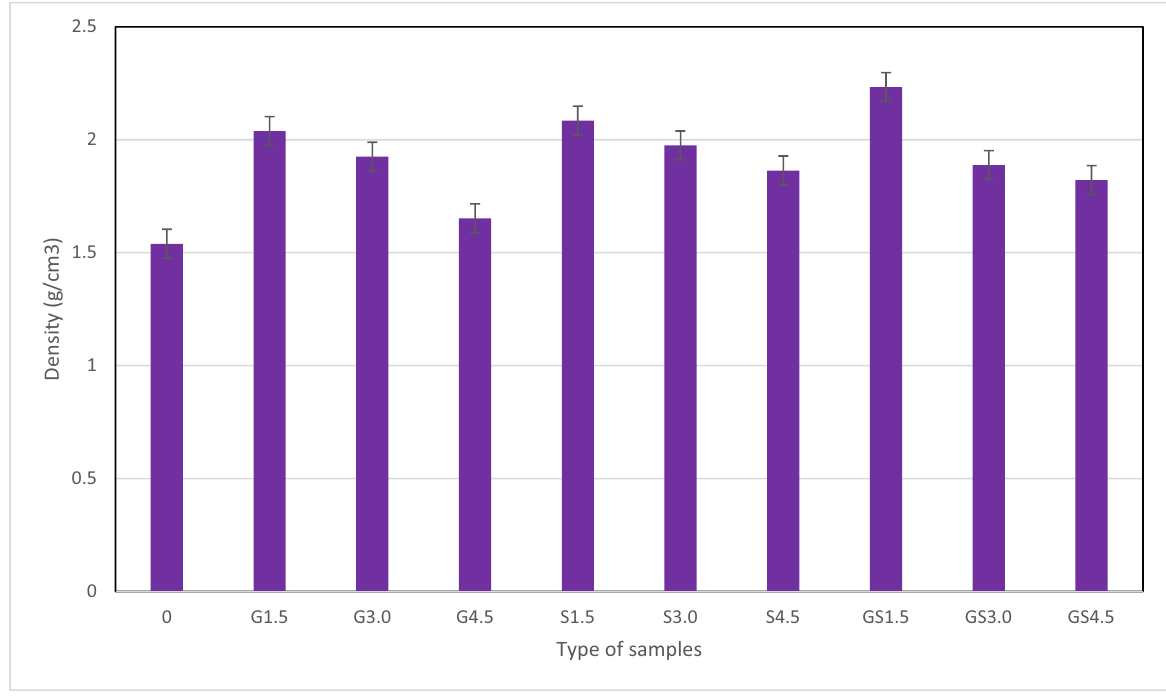
Figure 3: Density of bionanocomposite fi